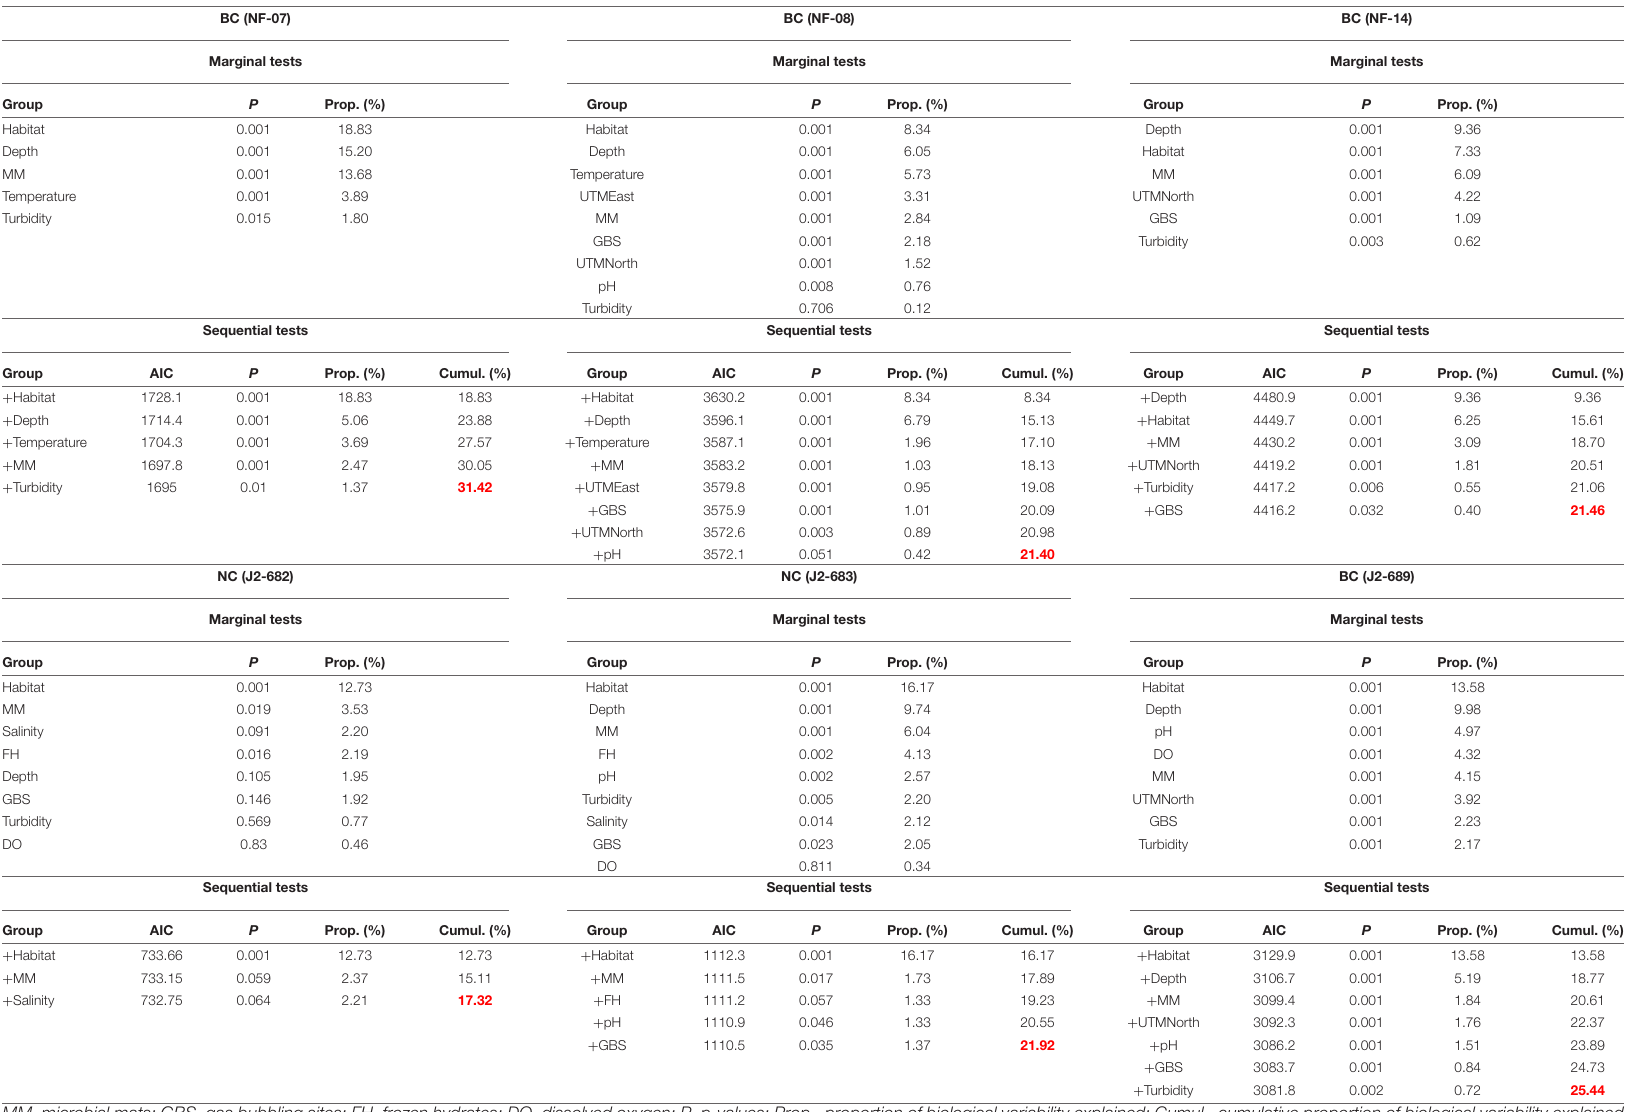
TABLE 4 | Outcome of distance-based linear modeling on the role of environmental parameters in explaining the variation of benthic megafauna in each of the six ROV dives at the Baltimore (BC) and Norfolk (NC)